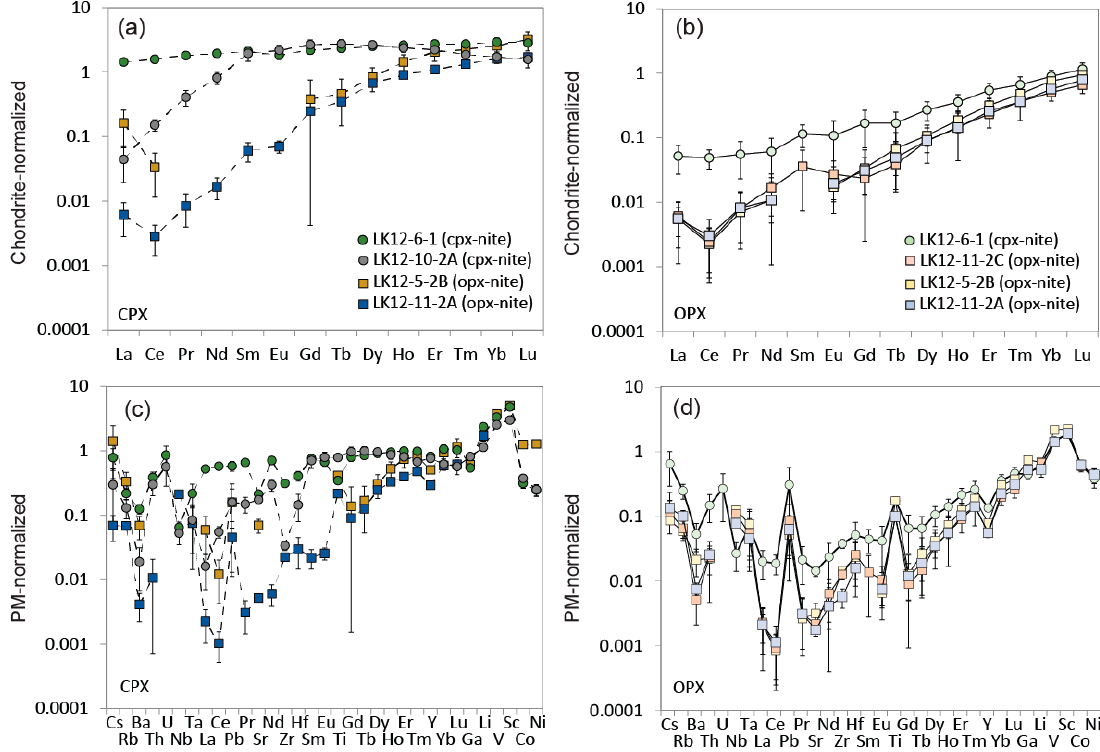
Figure 6. Average rare-earth element (REE) concentrations normalized to chondrite [42] in ( a ) CPX and ( b ) OPX in orthopyroxenites and clinopyroxenites. Average trace element concentrations normalized to primitive mantle (PM) [42] in ( c ) CPX and ( d ) OPX in the same pyroxenites. Error bars represent 2 standard error (2SE) for each element.